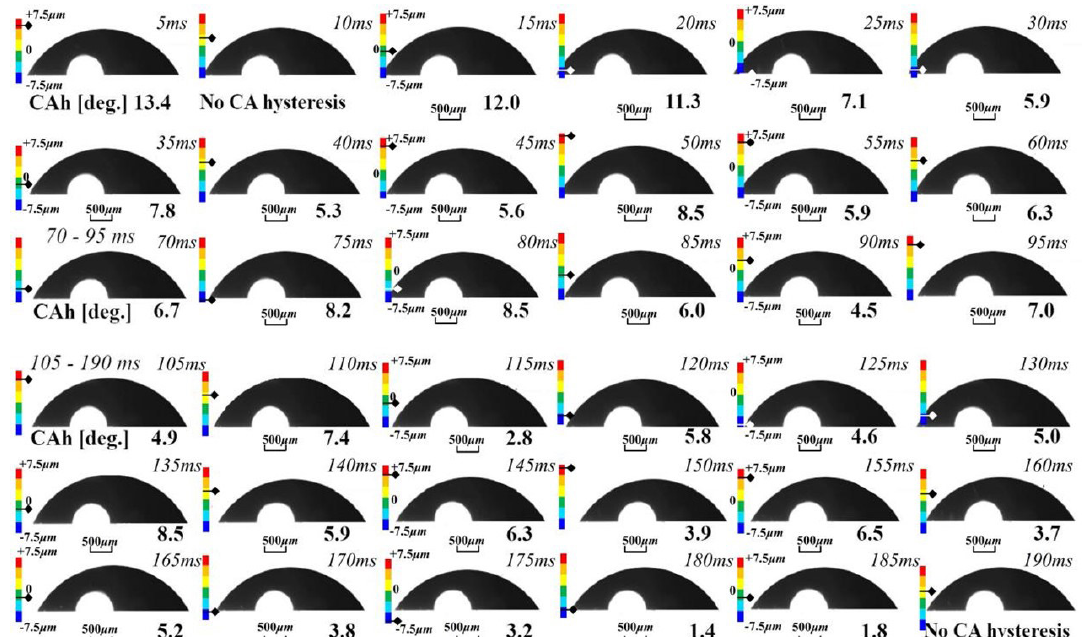
Figure 7. Images and screenshots of dynamic behaviors of Al/SiC wetting, the ultrasonic was primally activated, snapshots of dynamic CA hysteresis within time ranges 5 ms - 60 ms, 70 ms - 95 ms, and 105 ms - 190 ms.